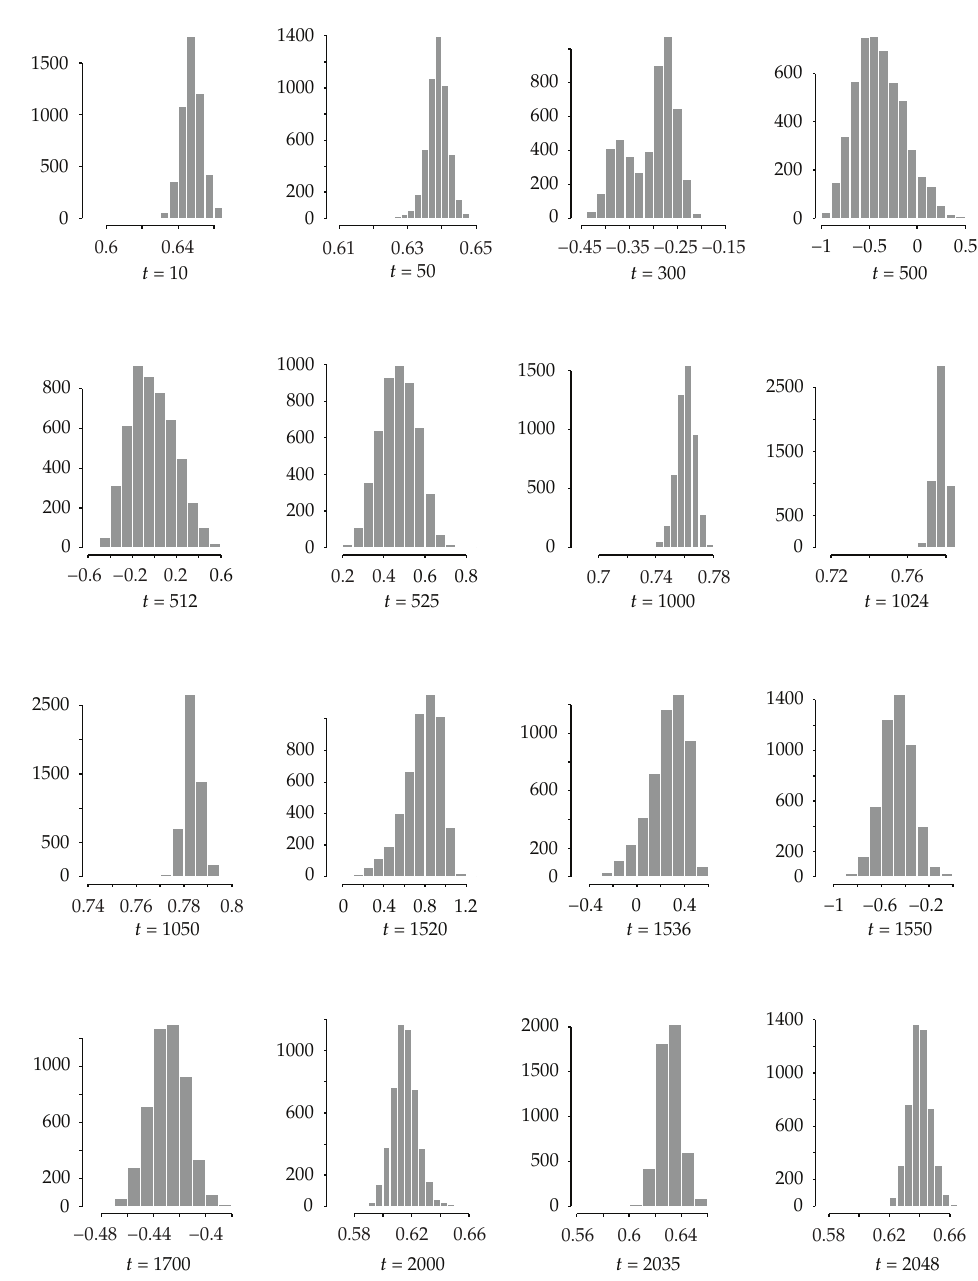
Figure 20: Example 5.2: Histograms of nonlinear estimate of δ 1 at some points of (cid:7) 0, 1 (cid:8) .